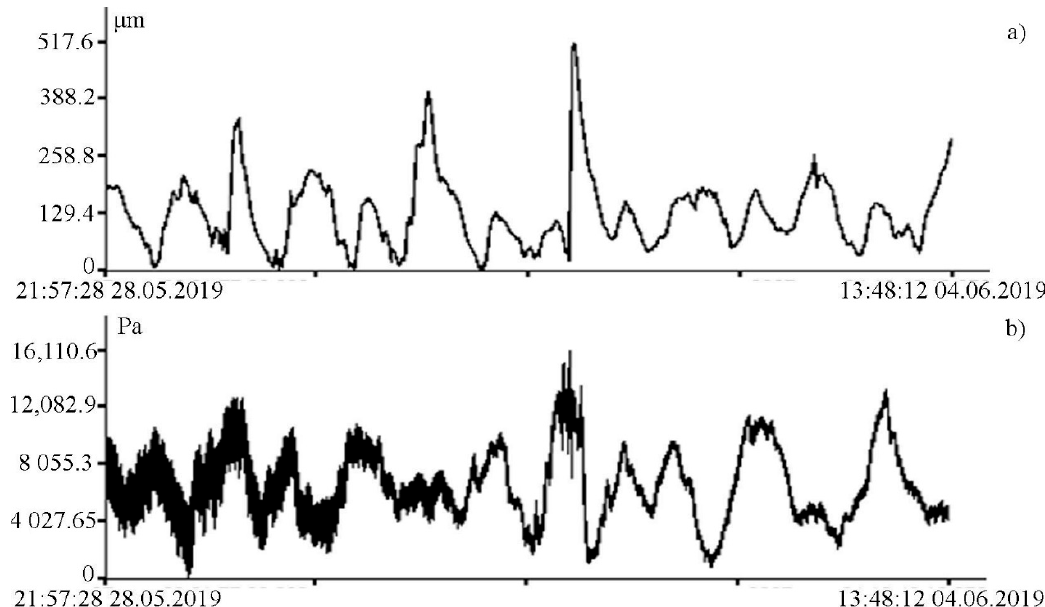
Figure 5. Synchronous records of the 52.5 m laser strainmeter ( a ) and the supersensitive detector of hydrosphere pressure variations ( b ).